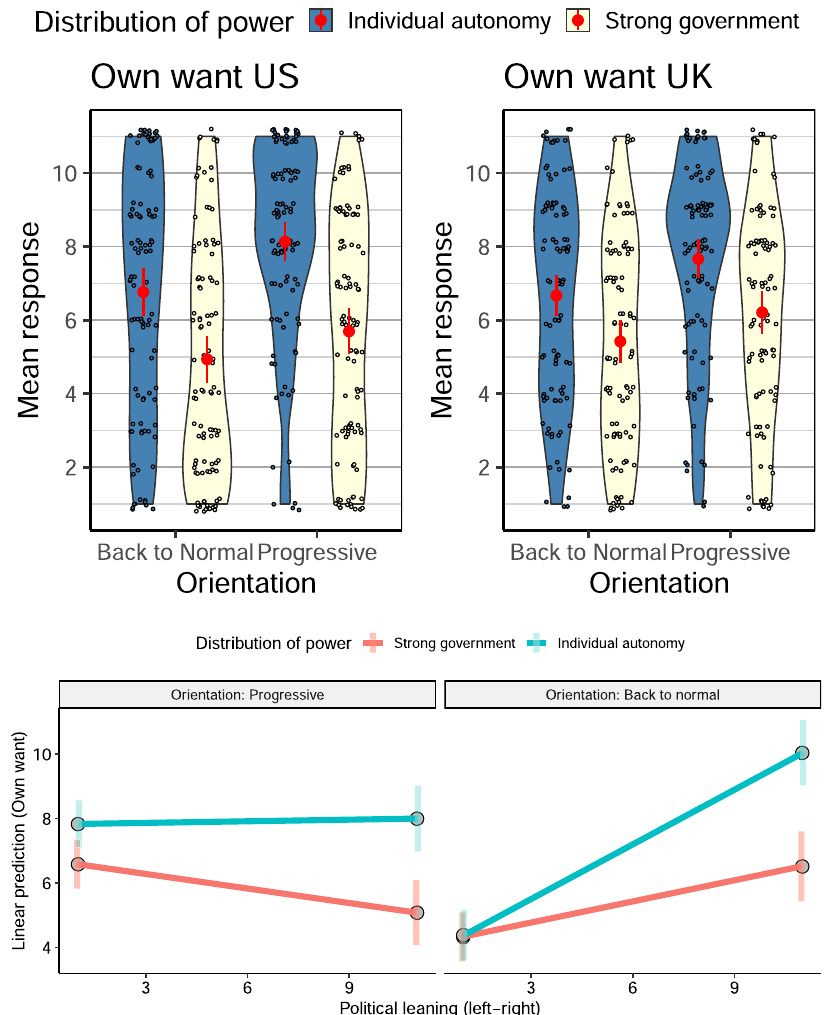
Fig. 6 Experiment 2: People ’ s own preferences for the scenarios as a function of the experimental variables. Top left panel shows data for the US sample and the top right panel shows responses for the U.K. sample. The red plotting symbols and error bars represent means and 95% con fi dence intervals. Data are jittered to avoid overprinting. The bottom panel shows estimated marginal means of the linear trends for political leaning (obtained by R package emmeans ) broken down by experimental variables but averaged across